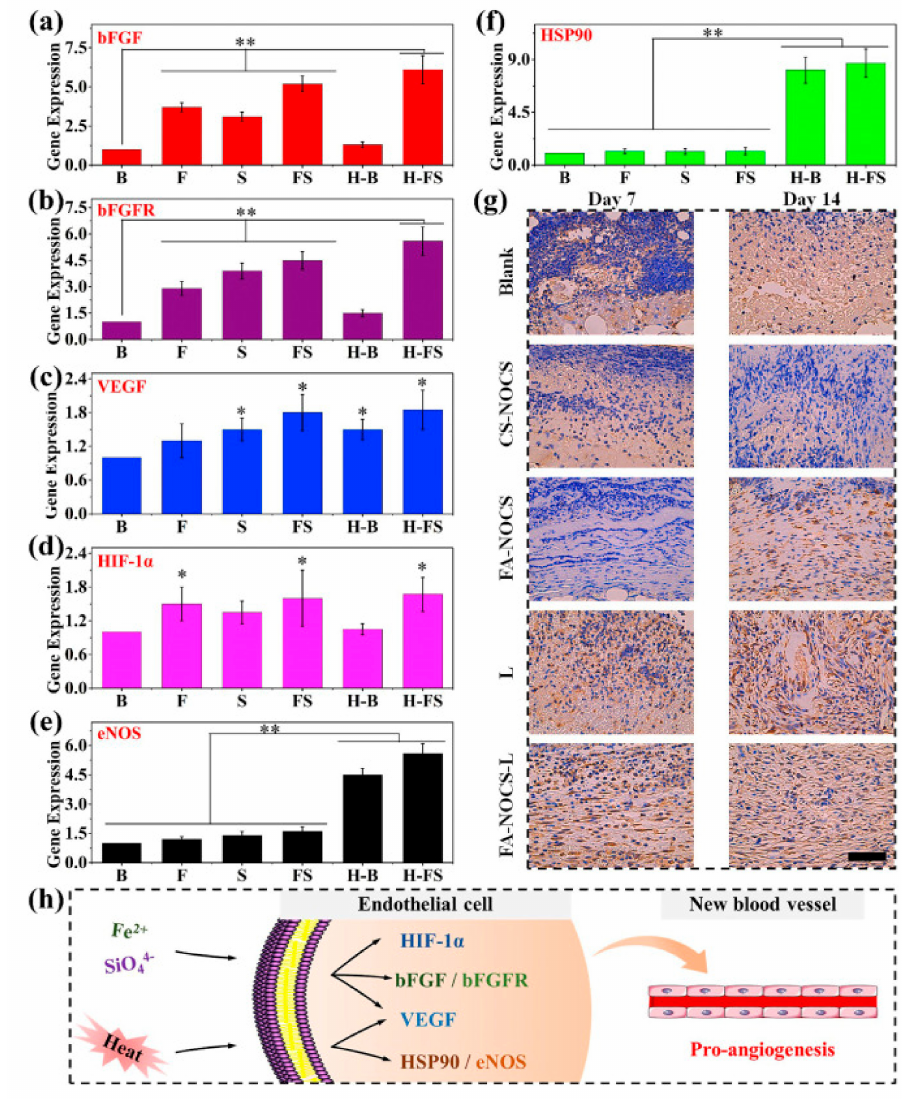
Figure 3. The effect of heat stimulation and Fe/Si ions on gene (in vitro) and protein (in vivo) expres- sion. ( a ) bFGF, ( b ) bFGFR, ( c ) VEGF, ( d ) HIF-1 α , ( e ) eNOS, ( f ) HSP90 gene expression of HUVECs at day 7. ( g ) Immunohistochemical staining for HSP90 (Blank: no treatment; CS-NOCS: calcium silicate- NOCS composite hydrogels without NIR irradiation; FA-NOCS: FA-NOCS composite hydrogels without NIR irradiation; FA–NOCS–L: FA-NOCS composite hydrogels with NIR irradiation (808 nm, 0.36 W/cm 2 , 15min/day, day 1–5); L: laser irradiation only; Bar = 50 µ m). ( h ) Possible activation mechanism of the combined effect of ions and thermal stimulation on angiogenesis. (B: blank; F: Fe 2+ containing medium; S: SiO 4 4 − containing medium; FS: Fe 2+ and SiO 4 4 − containing medium; H–B: heat treatment; H-FS: combination of heat and Fe 2+ and SiO 4 4 − ion treatment, * p <